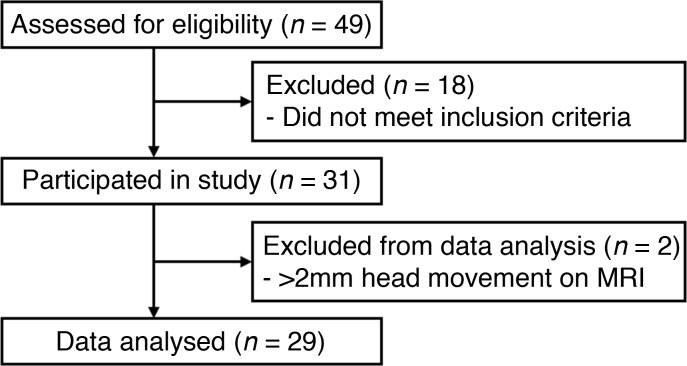
Participant recruitment and flow summary.